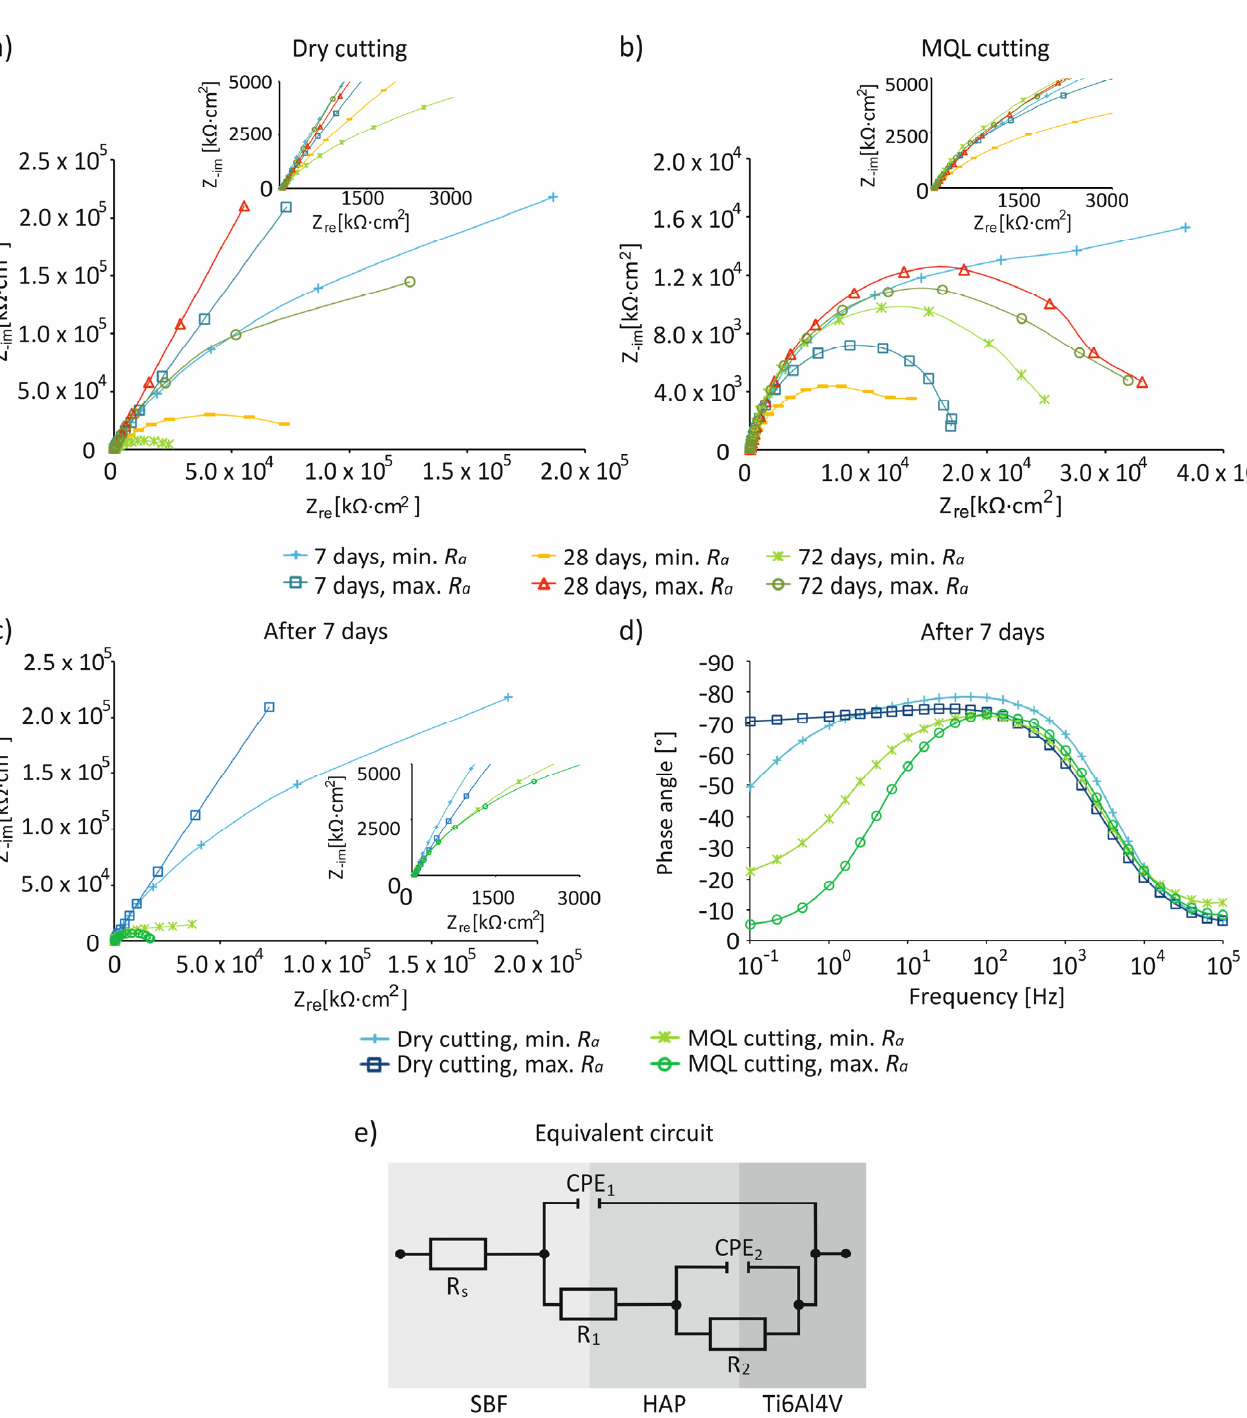
Figure 7. Niquist charts for samples of Ti6Al4V alloy after turning with R a min and R a max after 7, 28, and 72 days of storage in SBF, under dry ( a ) and MQL ( b ) conditions; comparison of impedance characteristics in Niquist representation ( c ) and Bode phase plots ( d ) with equivalent circuit illustrating the nature of samples ( e ). Table 4. Summary of Corrosion Resistance and Surface Bioactivity Results of Samples with R a min and R a max of Ti6Al4V Alloy after Turning under Ecological Cutting Conditions.